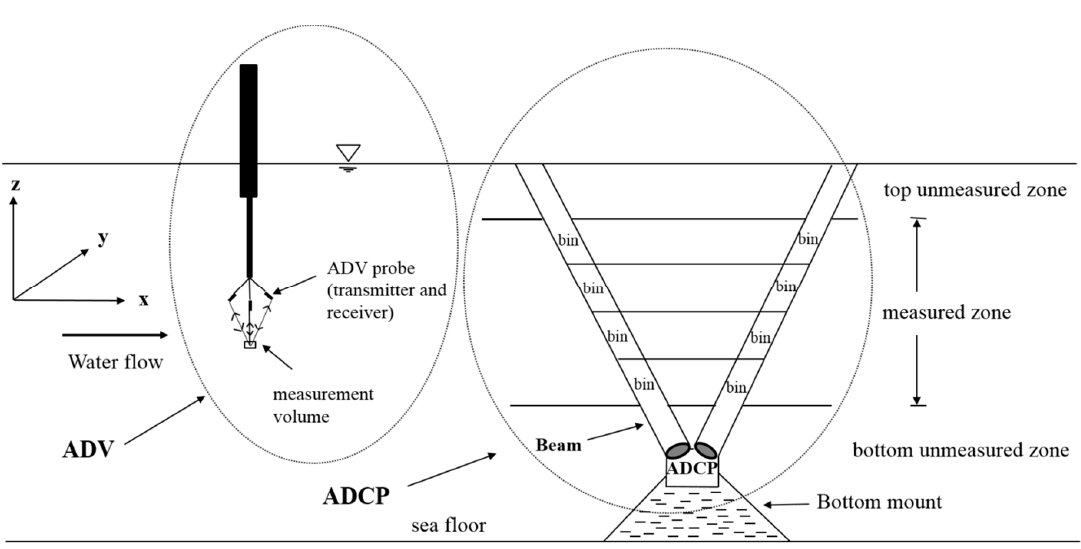
Figure 1. Schematic of an acoustic Doppler velocimeter (ADV) and typical bottom-mounted acoustic Doppler current profiler (ADCP) deployment.